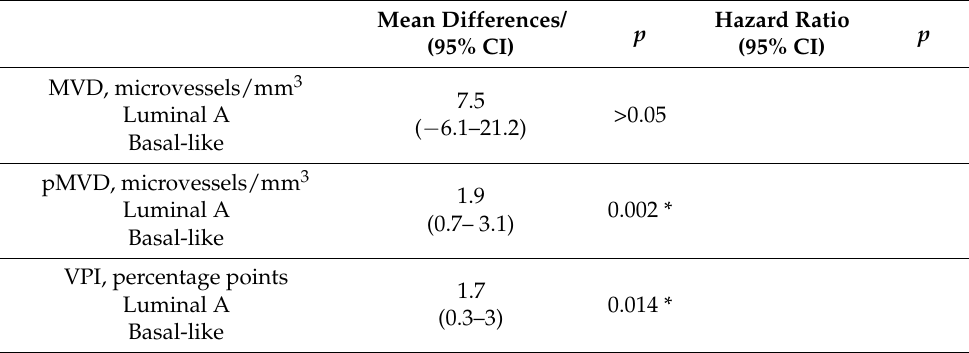
Table 1. Correlation between MVD, pMVD and VPI and prognosis in breast cancer Luminal A and basal-like